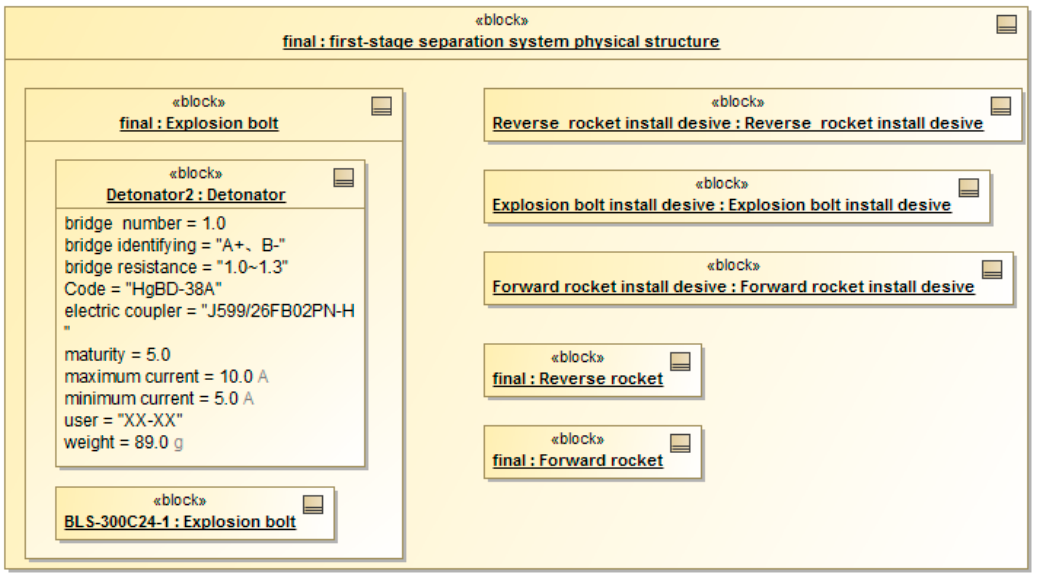
Figure 11. Physical architecture of first-stage separation